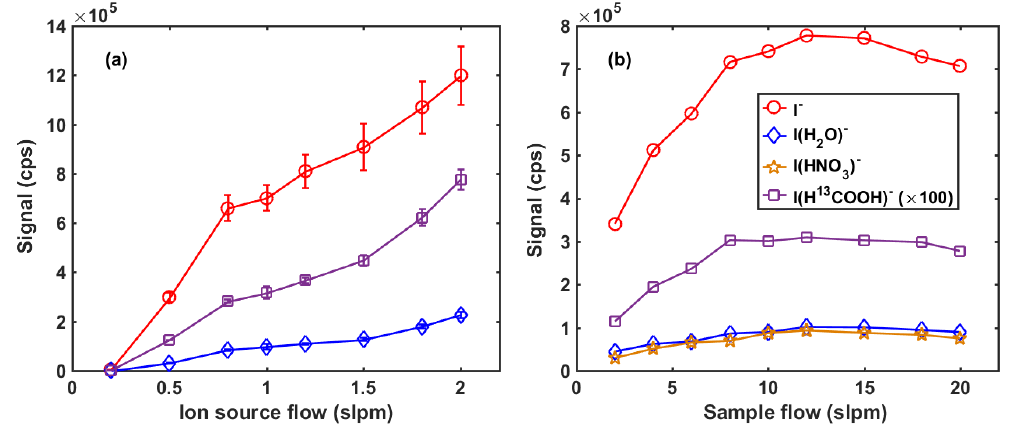
Figure 2. Dependence of ion signals on the ion source flow and sample flow. (a) Ion signals observed as a function of ion source flow during the sampling of humid room air (15mbar water vapor pressure) containing H 13 COOH at a flow of 10 standardLmin − 1 . (b) Ion signals observed during the sampling of humid room air containing H 13 COOH and HNO 3 gas flow rates of 2–20 standardLmin − 1 (the ratio of ion source flow/sample flow is fixed at 1:10). The signals for I (H 13 COOH) − in (a) and (b) are magnified 100